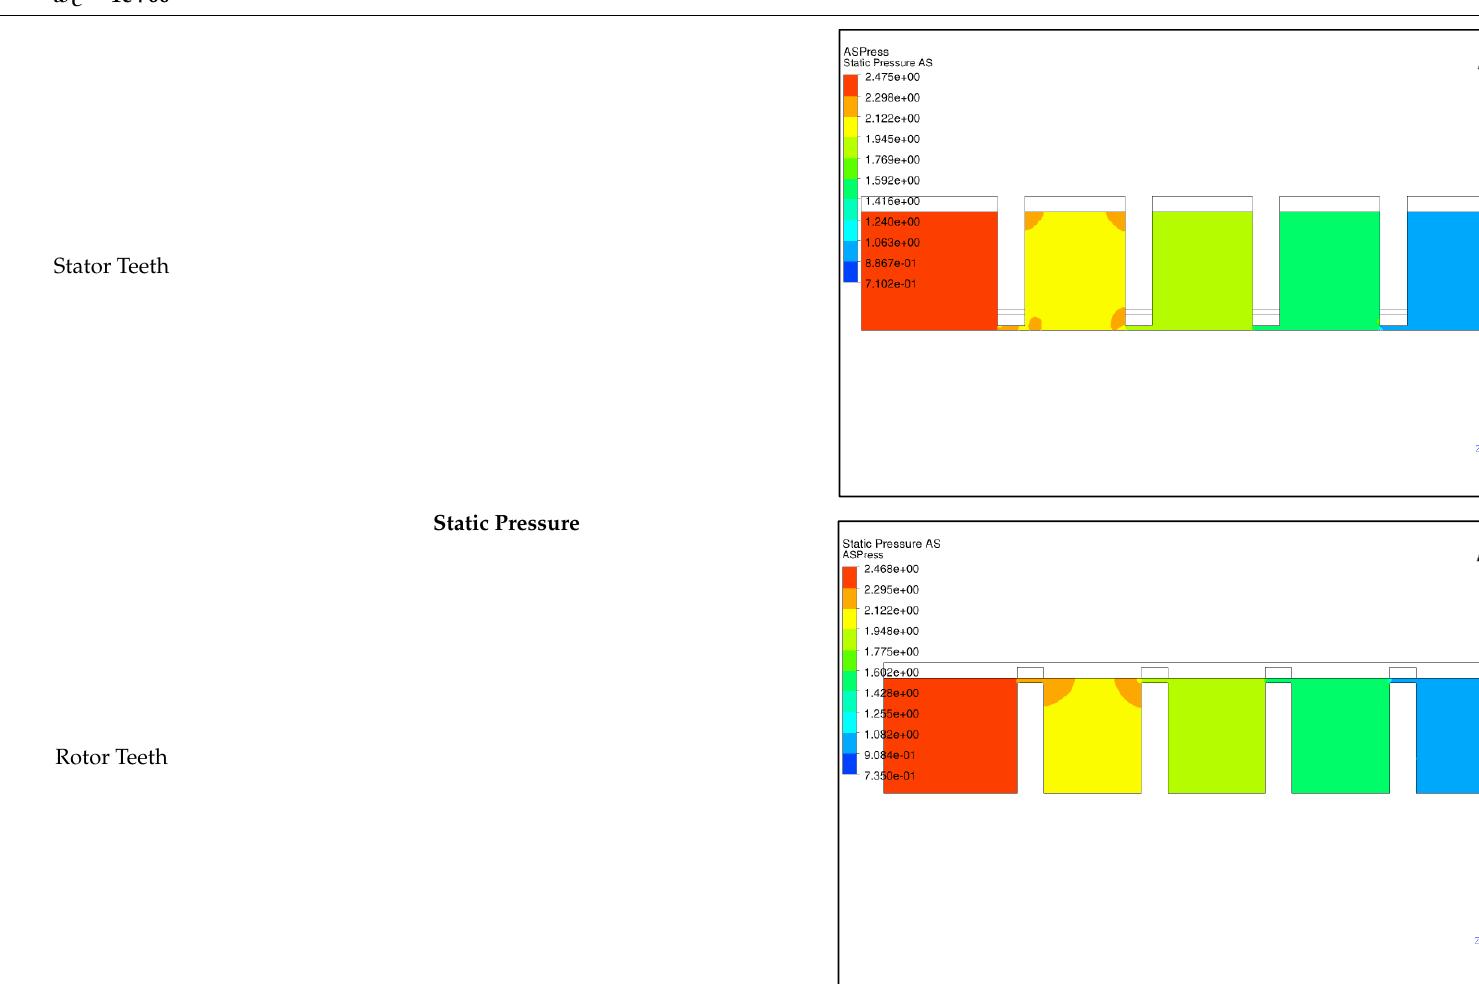
Table A7. Total temperature